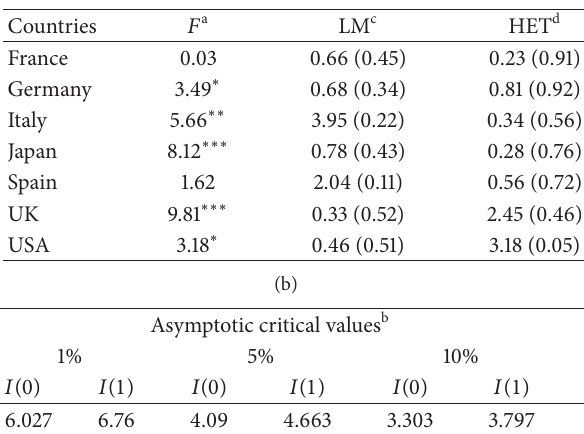
Table 2: ARDL Cointegration